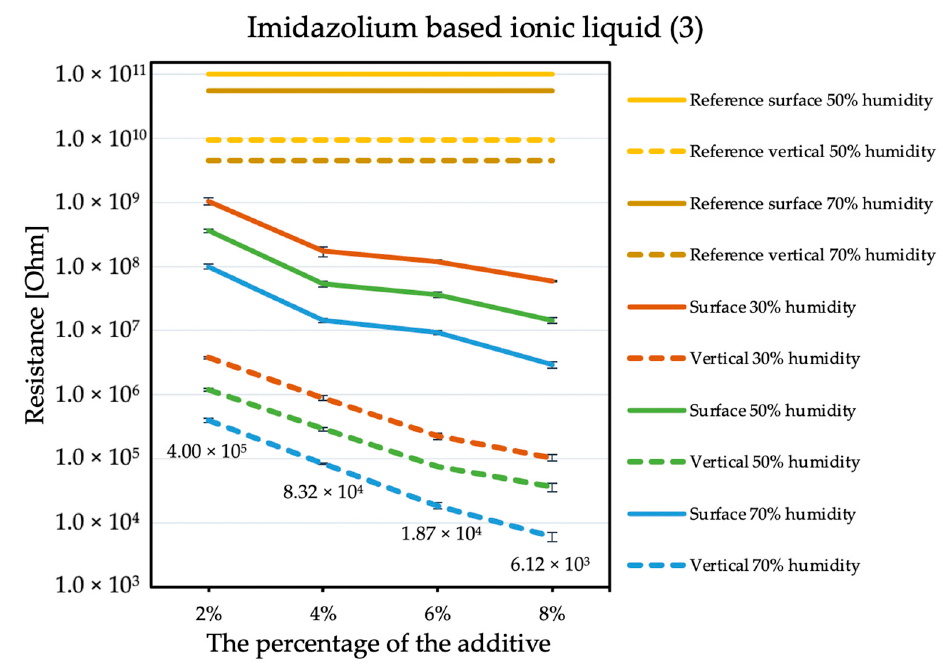
Figure 3 . Resistances of coatings with imidazolium based ionic liquid additive.